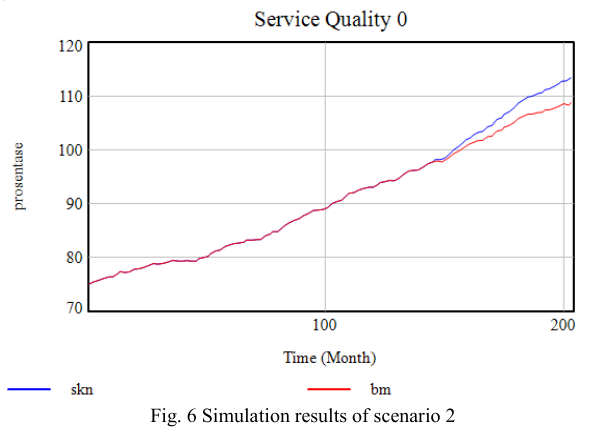
Fig. 6 Simulation results of scenario